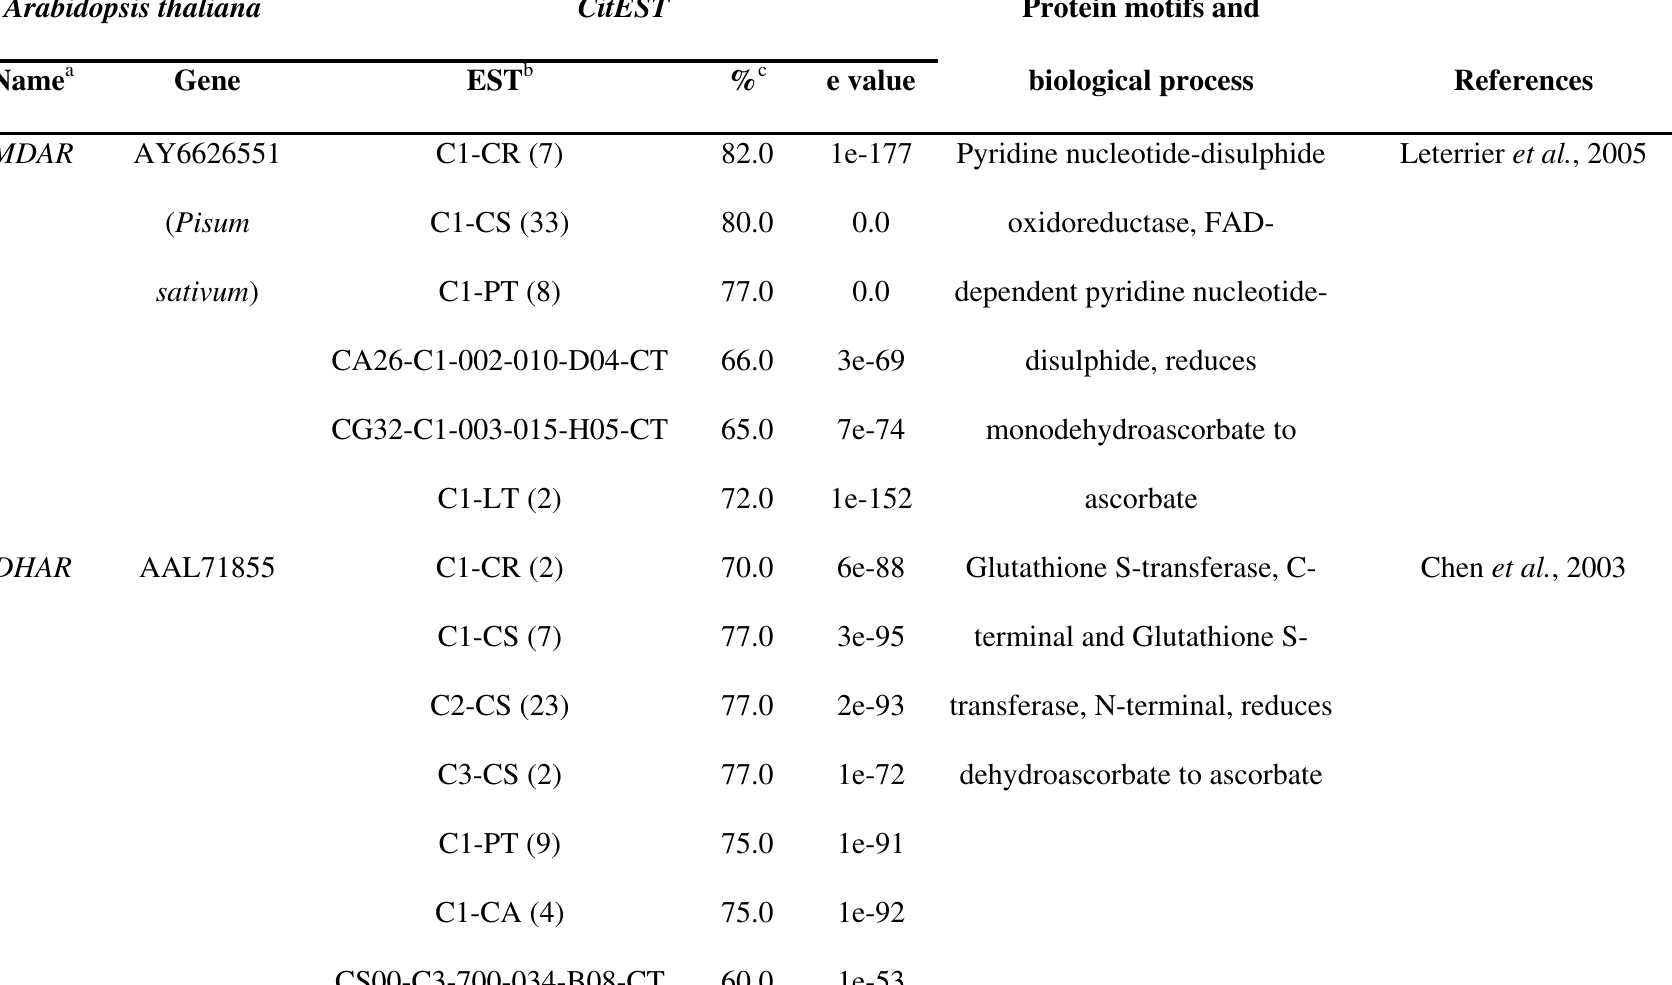
Table S9 – Citrus ESTs with homology to ascorbate-glutathione cycle-related protein families from Arabidopsis thaliana